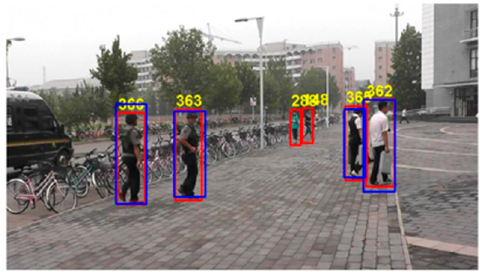
Figure 4. Example of the detected bounding box (blue color) and the ground truth (red color). The class label (ID) is annotated above the ground truth. The bounding box with the corresponding ID is used in the training process of the identification module if the intersection of overlap (IOU) is larger than 0.5.